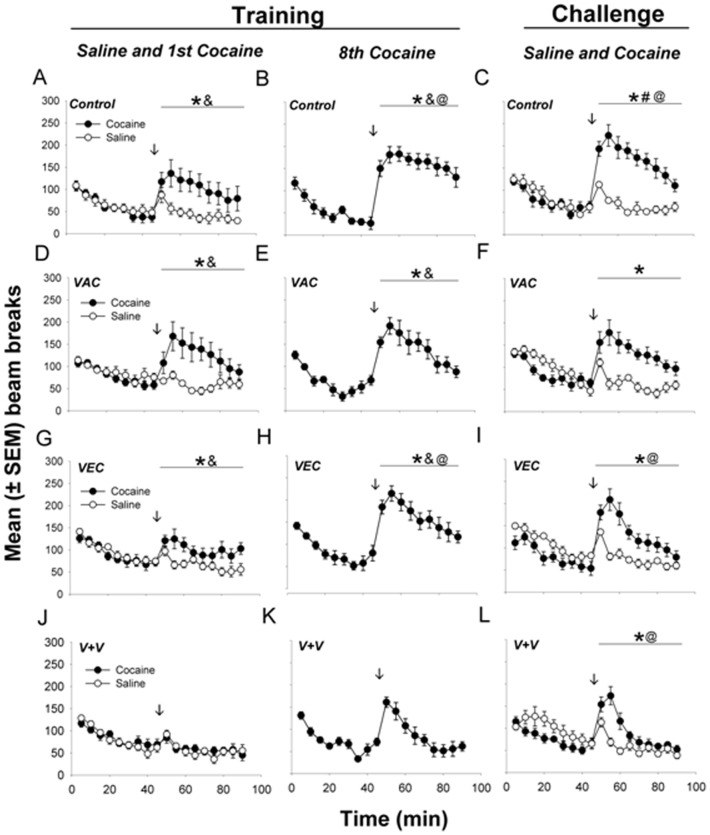
Combined vaccine and vector treatment reduces cocaine-induced locomotor activity even after repeated cocaine injections.Shown are beam breaks per 5 min interval (mean ± SEM). Left panels: initial two days of training phase. Middle panels: last day of training phase. Right panels: both days of challenge phase. Statistical significance: * significantly higher locomotor activity after cocaine injections compared to saline (p<0.05); & significantly higher cocaine-induced locomotor activity than in the VAC+VEC group (p<0.01); @ significantly higher cocaine-induced locomotor activity after the last cocaine injection compared to first injection (p<0.01); # significantly greater cocaine-induced locomotor activity in control group compared to all others (p<0.05).